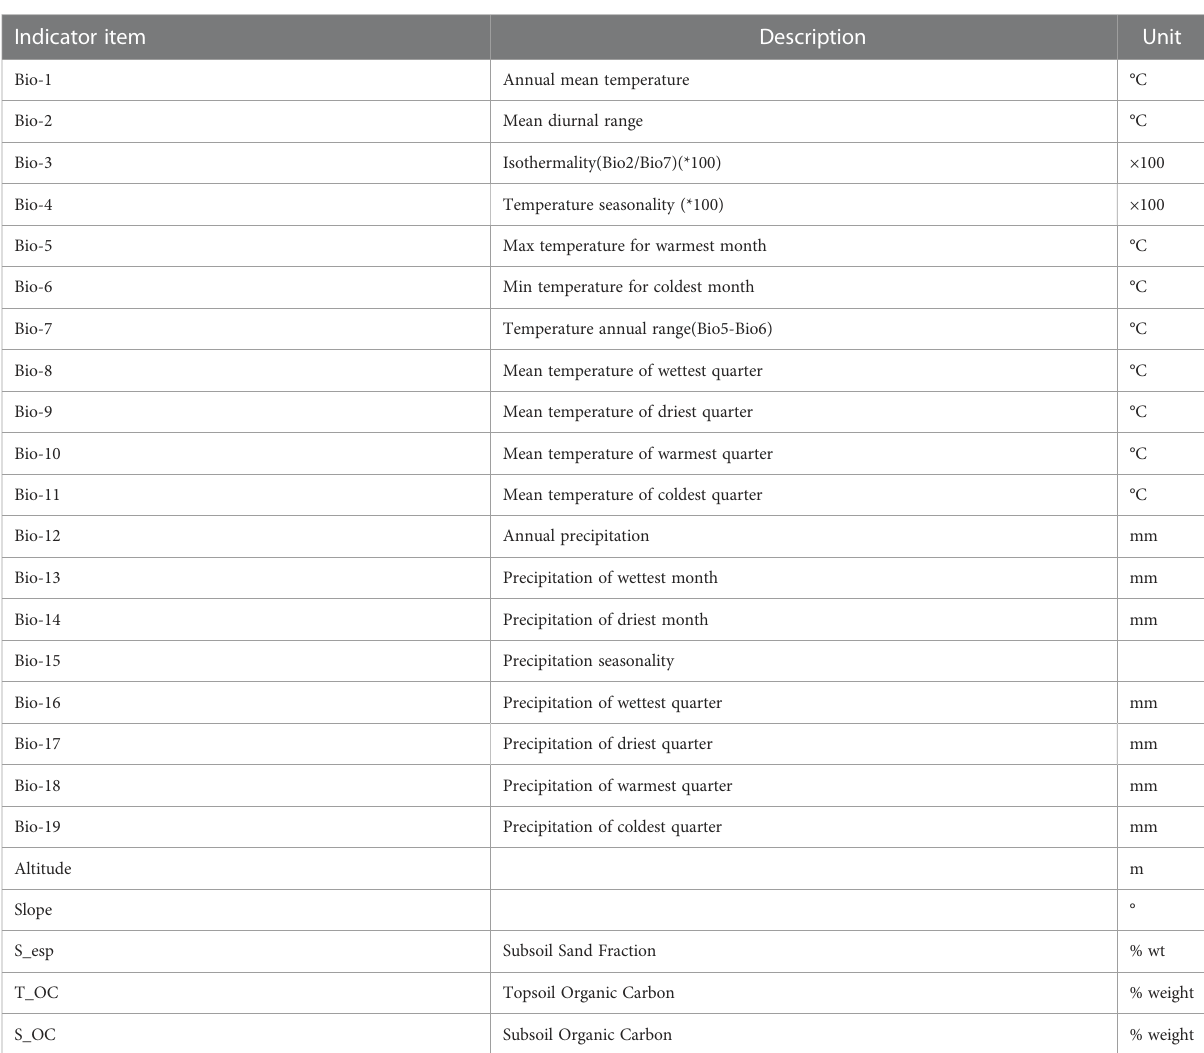
TABLE 1 Environmental